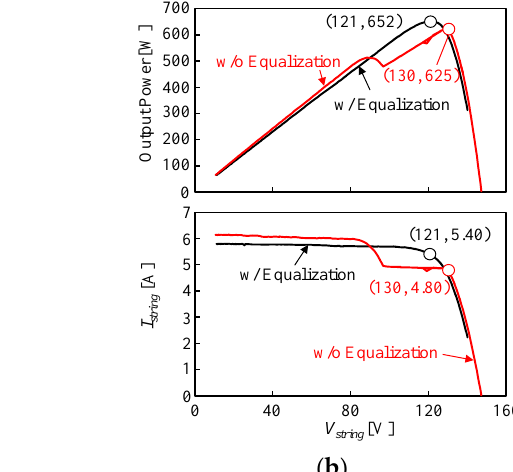
Figure 18. Experimental results of field testing. ( a ) Individual panel characteristics used for experiment; ( b ) Measured string characteristics with/without proposed DPP converter.